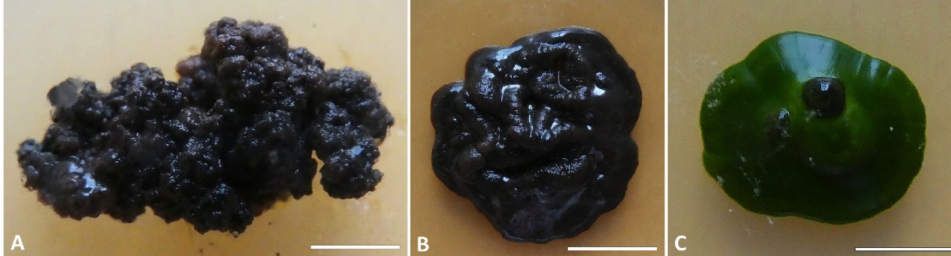
Figure 3. Colony appearance in the culture of Antarctolichenia onofrii: ( A ) the isolated strains of MNA-CCFEE6163 and ( B ) MUT 6552 alone, and ( C ) the strain MNA-CCFEE6574 grown together with the Stichococcus-like algae. Strains were grown on MEA (17 ◦ C, 20 µ mol fot · m − 2 · s − 1 , with a light/dark cycle of 14/10 h). Scale bars: ( A ) 3 mm; ( B ) 8 mm; and ( C ) 6